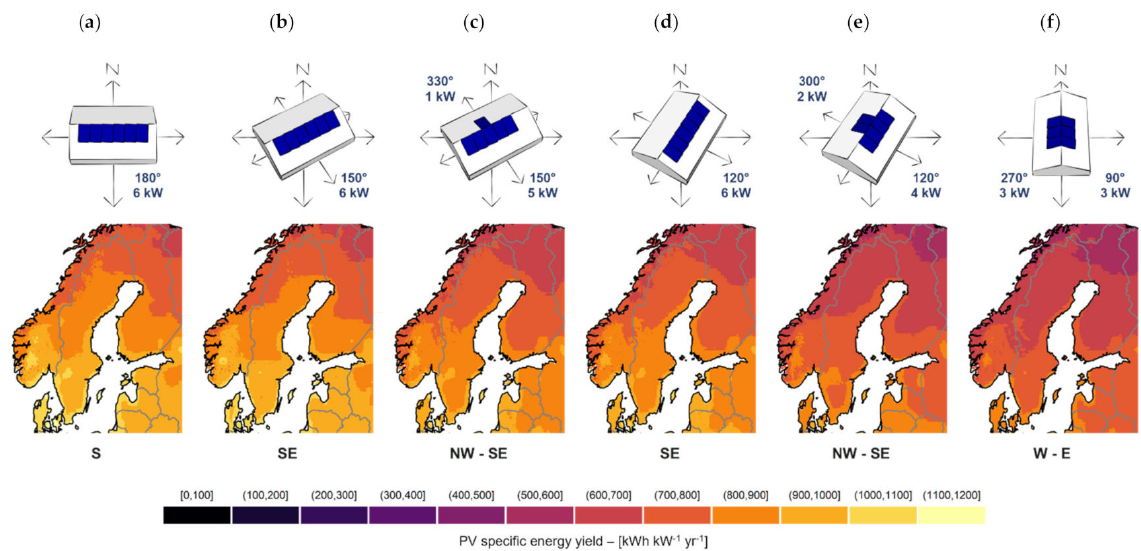
Figure 8. Yearly PV specific energy yield (E rel, PV , kWh · kW − 1 · yr − 1 ) maps of the Nordic and Baltic countries for roof- mounted PV systems at a 25 ◦ slope with an installed peak power (P PV,STC ) of 6 kW. The values were estimated using PVGIS version 5.1 assuming the solar cell technology was c-Si and the estimated system losses were 14%. The irradiance values used were from the ECMWF-ERA-5 dataset with a coverage period of 2005–2016 retrieved as a 0.1 ◦ × 0.1 ◦ grid both in latitude and longitude, extending from 54.5 ◦ N to 70 ◦ N in latitude and 4.5 ◦ E to 31.5 ◦ E in longitude. Depending on the orientation of the building and the distribution of the PV modules among the two roof directions, the studied system designs were: ( a ) 6 kW at azimuth 180 ◦ ; ( b ) 6 kW at azimuth 150 ◦ ; ( c ) 5 kW at azimuth 150 ◦ combined with 1 kW at azimuth 330 ◦ ; ( d ) 6 kW with azimuth 120 ◦ ; ( e ) 4 kW at azimuth 120 ◦ combined with 2 kW at azimuth 300 ◦ ; ( f ) 3 kW at azimuth 90 ◦ combined with 3 kW at azimuth 270 ◦